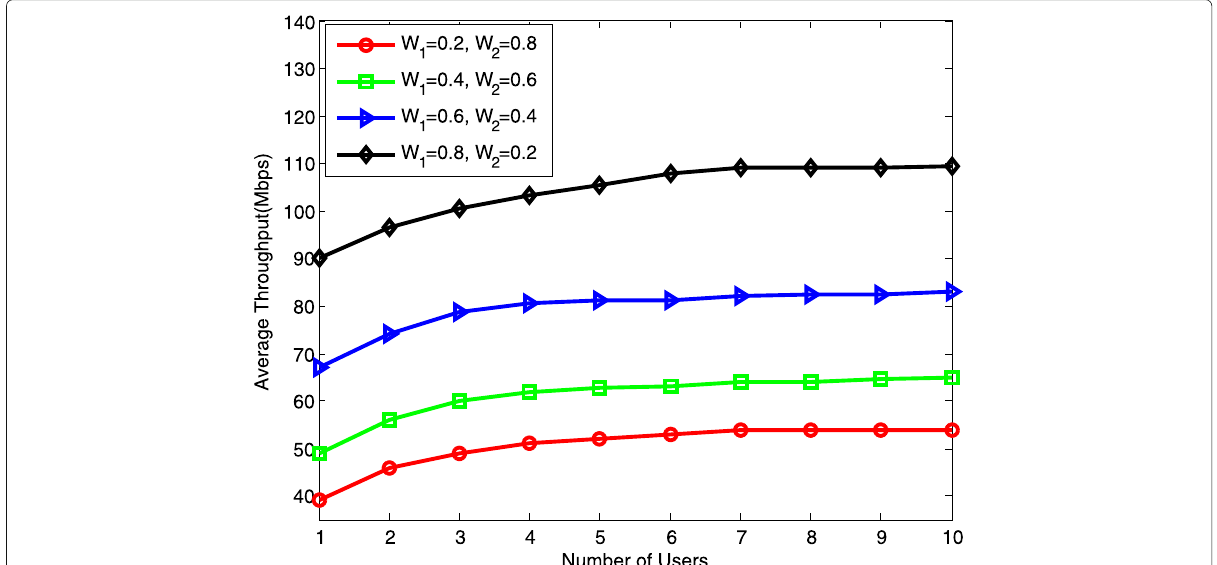
Fig. 4 Average throughput results with different weight combinations and number of